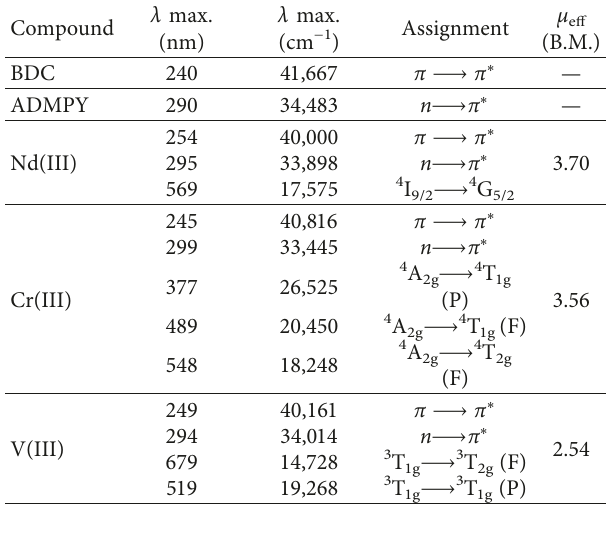
Table 4: Absorption spectra and magnetic moment of metal complexes.